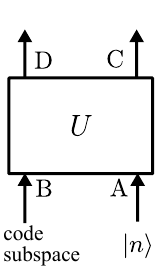
Figure 14 . A black hole entangled through a codeword subspace. An infalling observer measures n on A , and quantum entanglement between C and D is j i